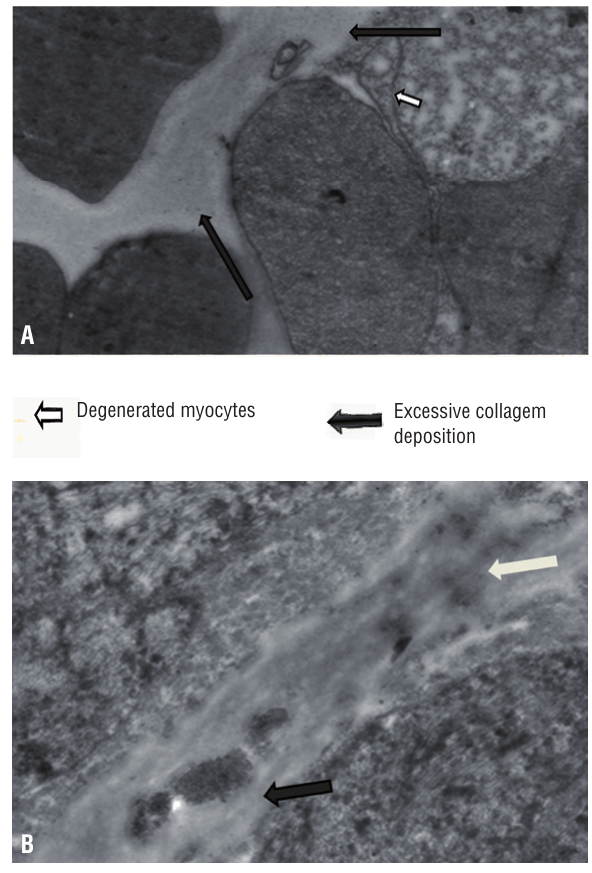
Figure 4 - a) Widened intercellular spaces with excessive collagen deposition along with degenerative myocytes (X- 25860) and 4b) Excessive Collagen with Hyperelastosis (X-22380) with black arrow shows collagen and red arrow shows elastin.